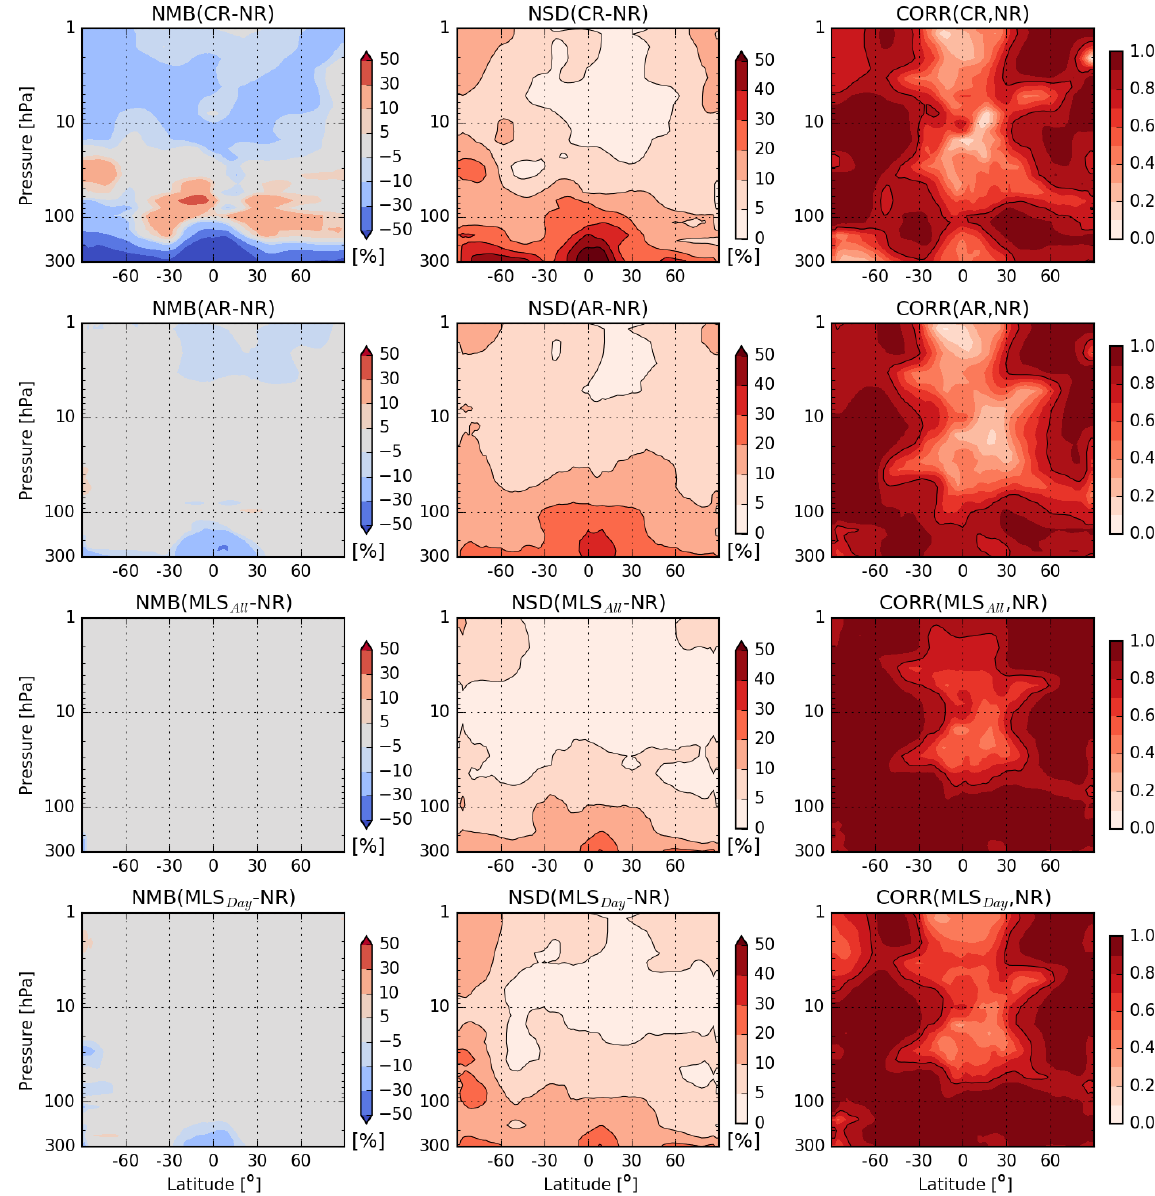
Figure 10. Top row: statistical differences between NR and CR for the period 15 June–25 October 2009: the mean bias (NR − CR) normalized by the mean of NR (NMB, %, left), the associated normalized standard deviation (NSD, %, centre) and the sample correlation coefficients between NR and CR (CORR, dimensionless, right). Black isolines in the centre plots are shown between each percentage decade, while in the right plot a single isoline shows the 0.8 correlation. Second row: the same as the top row but for the comparison between NR and AR. Third row: the same as the top row but for the comparison between NR and MLS All . Fourth row: the same as the top row but for the comparison between NR and MLS Day